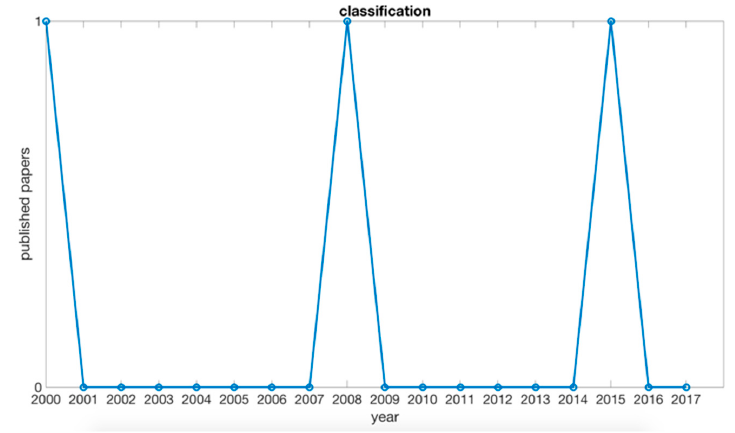
Figure 5. Number of published papers by year for classification research papers.